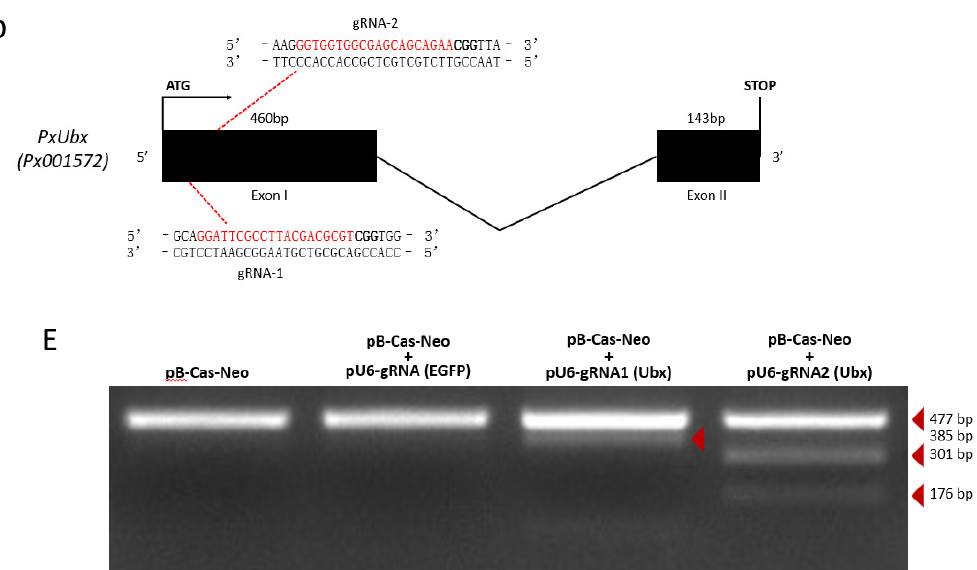
Figure 5. CRISPR/Cas9 system knocks out exogenous and endogenous genes in the P. xylostella cell lines. ( A ) Plasmids for RNAi and CRISPR/Cas9 system. ( B ) Fluorescence images of CRISPR/Cas9 system and RNAi knocking out EGFP. photographed by laser confocal, exposure time and excitation light intensity are consistent during shooting. ( C ) The relative expression of EGFP after CRISPR/Cas9 system and RNAi knockout. * indicates significant difference (Duncan, p < 0.05), ** indicates highly significant difference (Duncan, p < 0.01). ( D ) The P. xylostella endogenous gene PxUbx and its selected targets. ( E ) Cleavage bands generated by T7 endonuclease I digestion after CRISPR/Cas9 targeting PxUbx